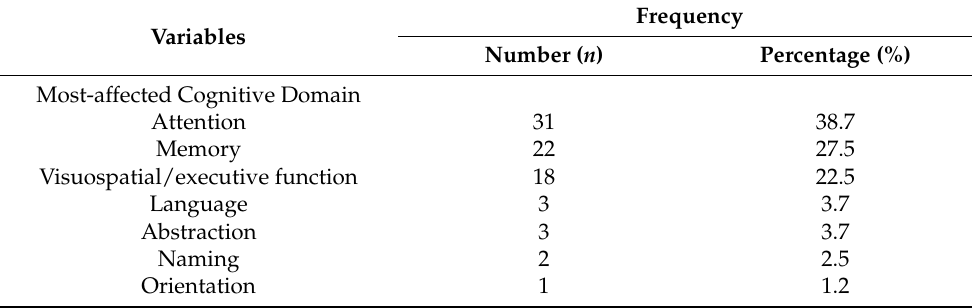
Table 3. Descriptive Analysis of Cognitive Domains ( n = 80).